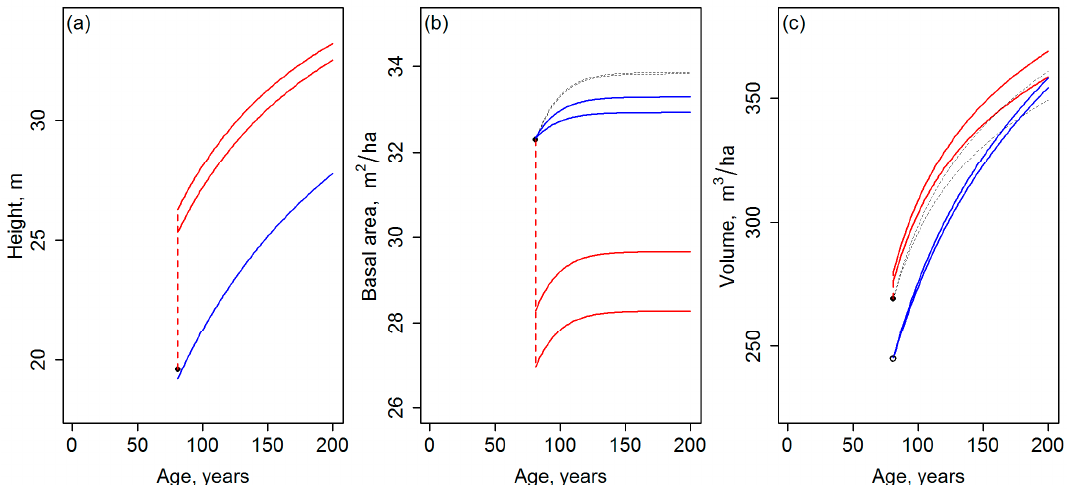
Figure 3. A graphical comparison of growth projections assuming different inputs and either the template matching or a direct use of the GYPSY models; ( a ) top height; ( b ) basal area; and ( c ) total volume. As in Figure 2, the black and red lines indicate the attribute-specific candidate curves and final curves of the template matching, respectively. Blue lines indicate the projections obtained by inserting the inputs of template matching directly to the underlying GYPSY models (the blue line is precisely overlapping the black one in ( a )). Two lines of the same color depict the difference resulting from assuming the two N ini parameter sequences, when applicable (distinguishing between the two curves is not seen necessary). As in Figure 2, the broken vertical lines show the difference between the observations (black dots) and projections at the age of the observations. An open circle is drawn to indicate the volume estimate ( c ) obtained by using the sequences of ( a , b ) as the inputs of Equation (4).